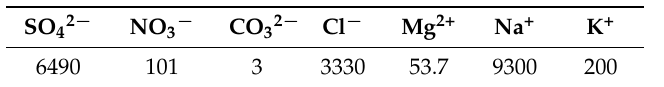
Figure 1. Morphology of the sandy soil. Table 2. Ionic composition of the red soil in aqueous extract, mg · kg − 1 .